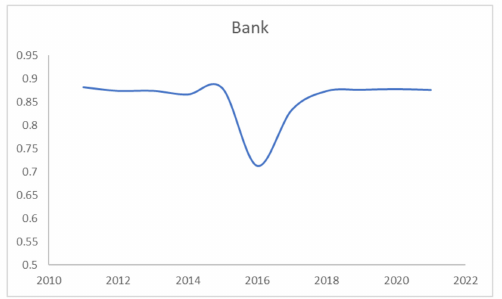
Figure 9. Trend of the reliability of the hot spot strength for drug crimes in the Bank cluster.